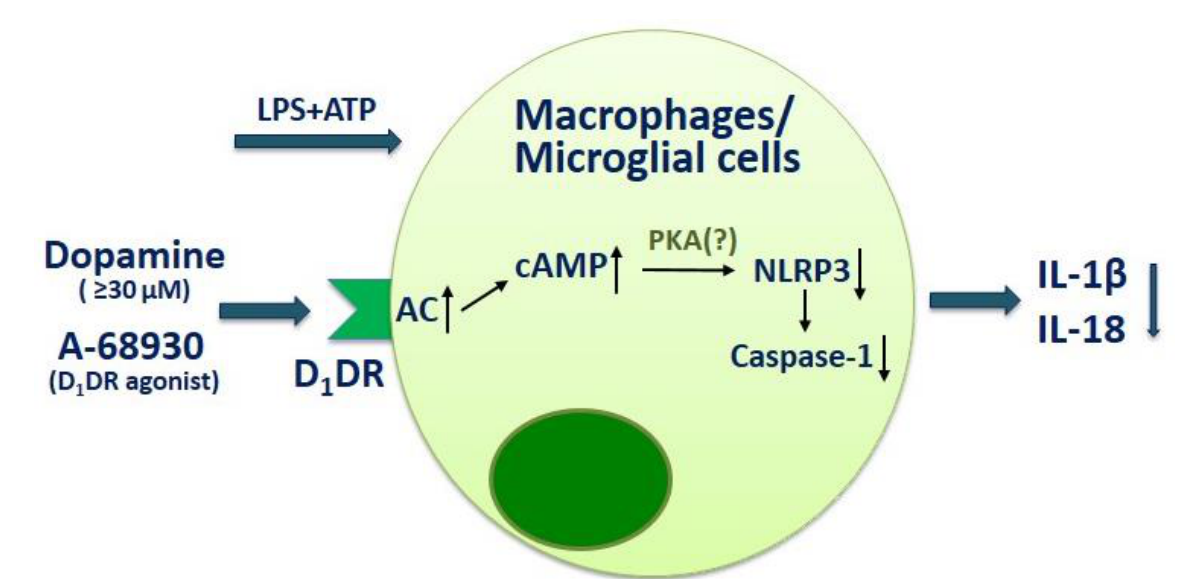
Figure 3. The influence of dopamine on macrophages and microglial cell function. D 1 DR—D 1 -dopaminergi receptor; CA—adenylyl cyclase; cAMP—cyclic adenosine monophosphate; PKA—protein kinase A; LPS—lipopolysaccharide; ATP— adenosintriphosphat.